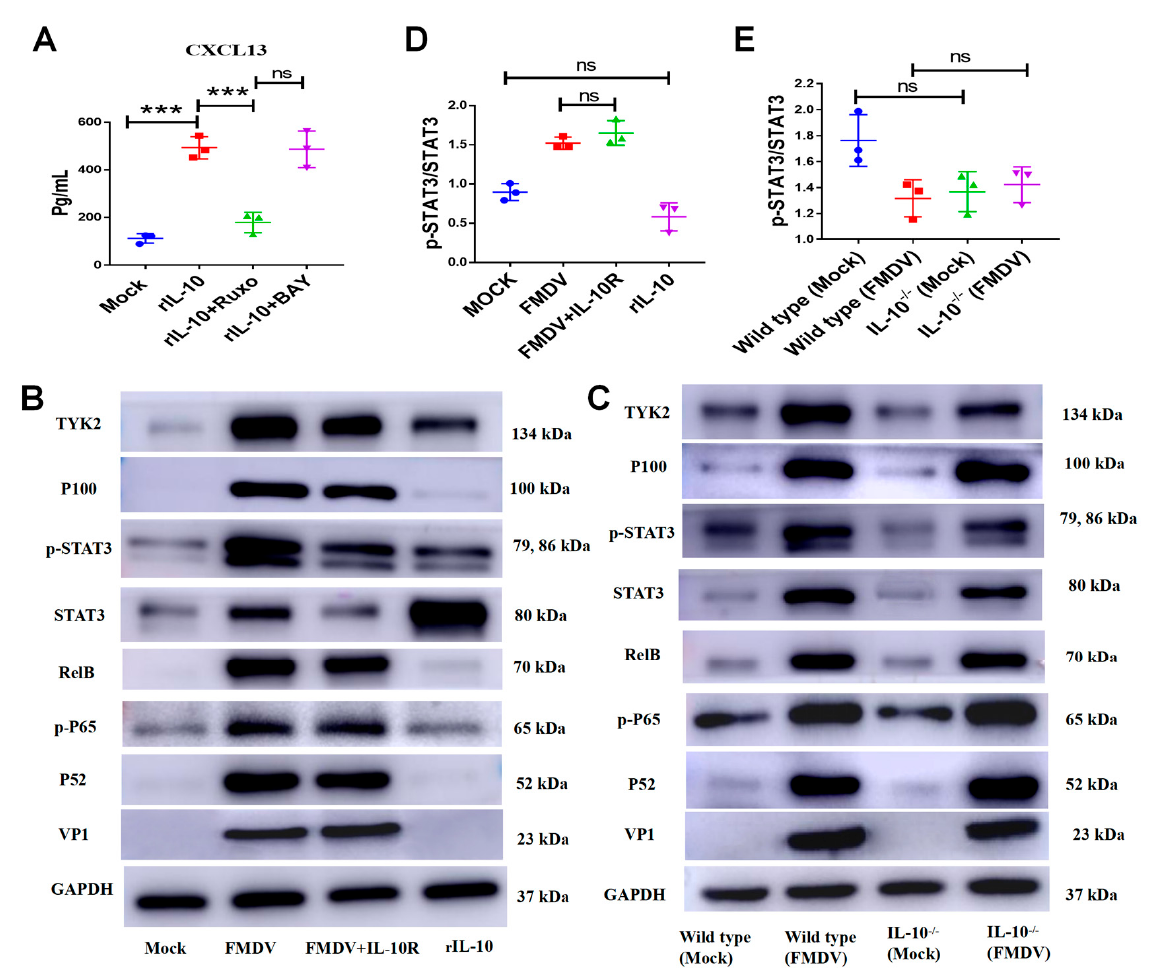
Figure 6. IL-10 induces CXCL13 expression in BMDMs by activating JAK/STAT signaling pathway. ( A ) The CXCL13 concentration in BMDMs followed the rIL-10 induction and treated with BAY or ruxolitinib at the same time. The expressions of VP1, P52, p-P65, RelB, P100, STAT3, p-STAT3, TYK2 and GAPDH in cell lysates of BMDMs, BMDMs infected with FMDV, BMDMs treated by anti-IL-10R antibody and infected with FMDV, and BMDMs stimulated with rIL-10 at 20 ng/mL ( B ) and in cell lysates of BMDMs, BMDMs infected with FMDV, IL-10 -/- BMDMs, and IL-10 -/- BMDMs infected with FMDV ( C ) were analyzed by Western blotting. The gray value ratio of p-STAT3/STAT3 in BMDMs, BMDMs infected with FMDV, BMDMs treated by anti-IL-10R antibody and infected with FMDV, and BMDMs stimulated with rIL-10 at 20 ng/mL ( D ) and in BMDMs, BMDM infected with FMDV, IL-10 -/- BMDMs, and IL-10 -/- BMDMs infected with FMDV at 24 hpi ( E ). Significance was detected using unpaired t test. ***, p ≤ 0.001. While ns indicates a non-statistically significant difference ( p > 0.05).